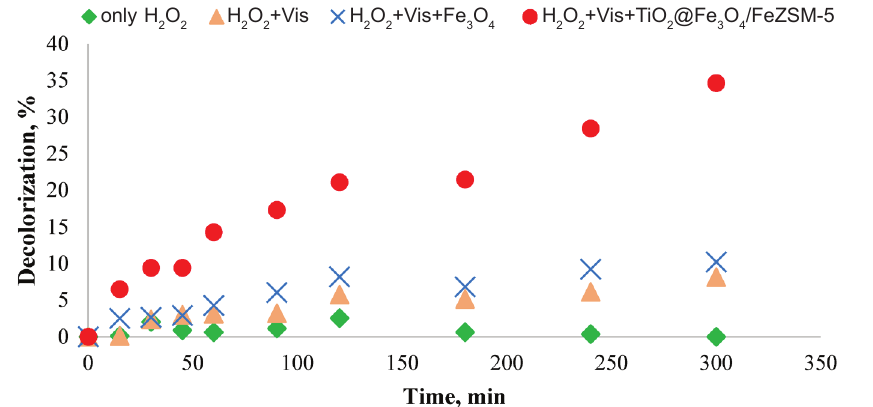
Fig. 4 – Blank experiments for decolorization of Rh